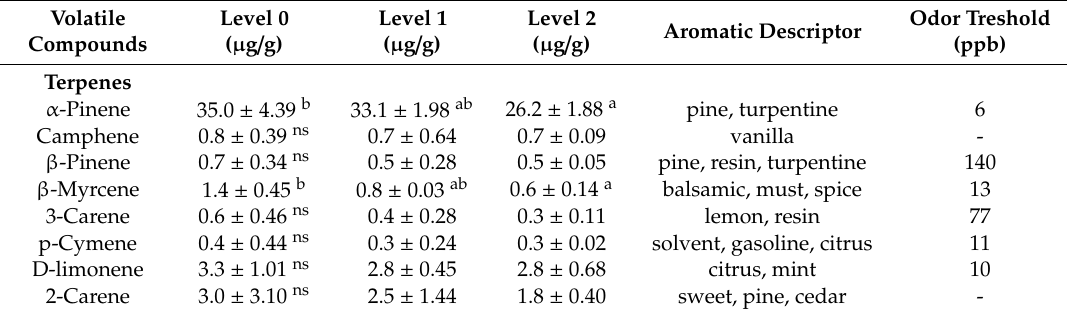
Table 3. Volatile compounds ( µ g / g) of pistachio nuts, aromatic description and odor threshold (ppb) a ff ected by di ff erent levels of water stress.